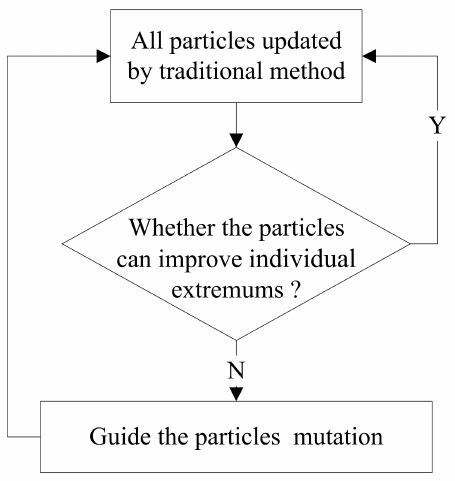
Figure 1. The procedure of the guided mutation strategy.